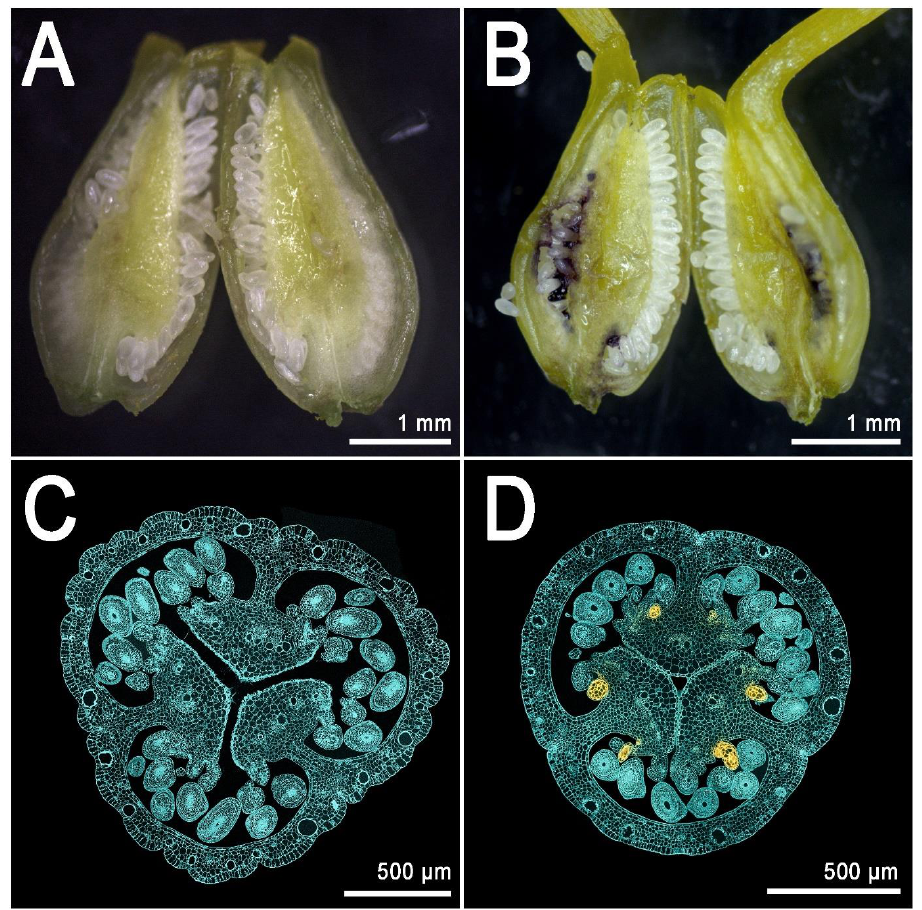
Figure 5. Comparison between contrasting (glanded and glandless) phenotypes of pistils of Hypericum perforatum . ( A ): Transverse section of a glandless pistil from an open flower of the genotype H06-1877; ( B ): Transverse section of a glanded pistil from on open flower of the genotype HyPR-09. Dark glands are visible on the surface of the placental tissue and under the layer of (white) developing ovules. ( C ): Cross section of a pistil (genotype H06-1877) observed under the confocal microscope. No hypericin fluorescence is detected. ( D ): Cross section of a pistil (genotype H06-1877) observed under the confocal microscope. Hypericin fluorescence signal (in yellow) is localized in the placental dark glands. Photos by Twan Rutten and Paride Rizzo.